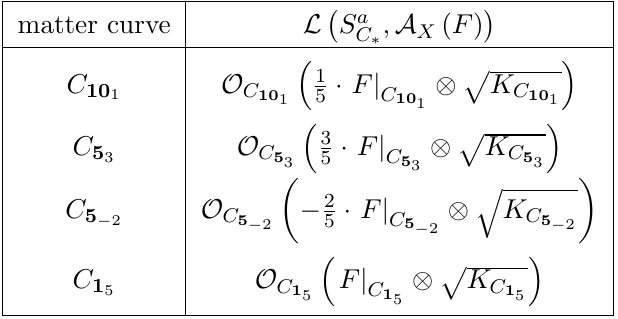
Table 5. The massless spectrum of states localised on the various matter curves in the presence of the (cid:13)ux A X ( F ) [29, 31] with F 2 Pic( B 3 ) is counted by the sheaf cohomologies of the line bundles listed